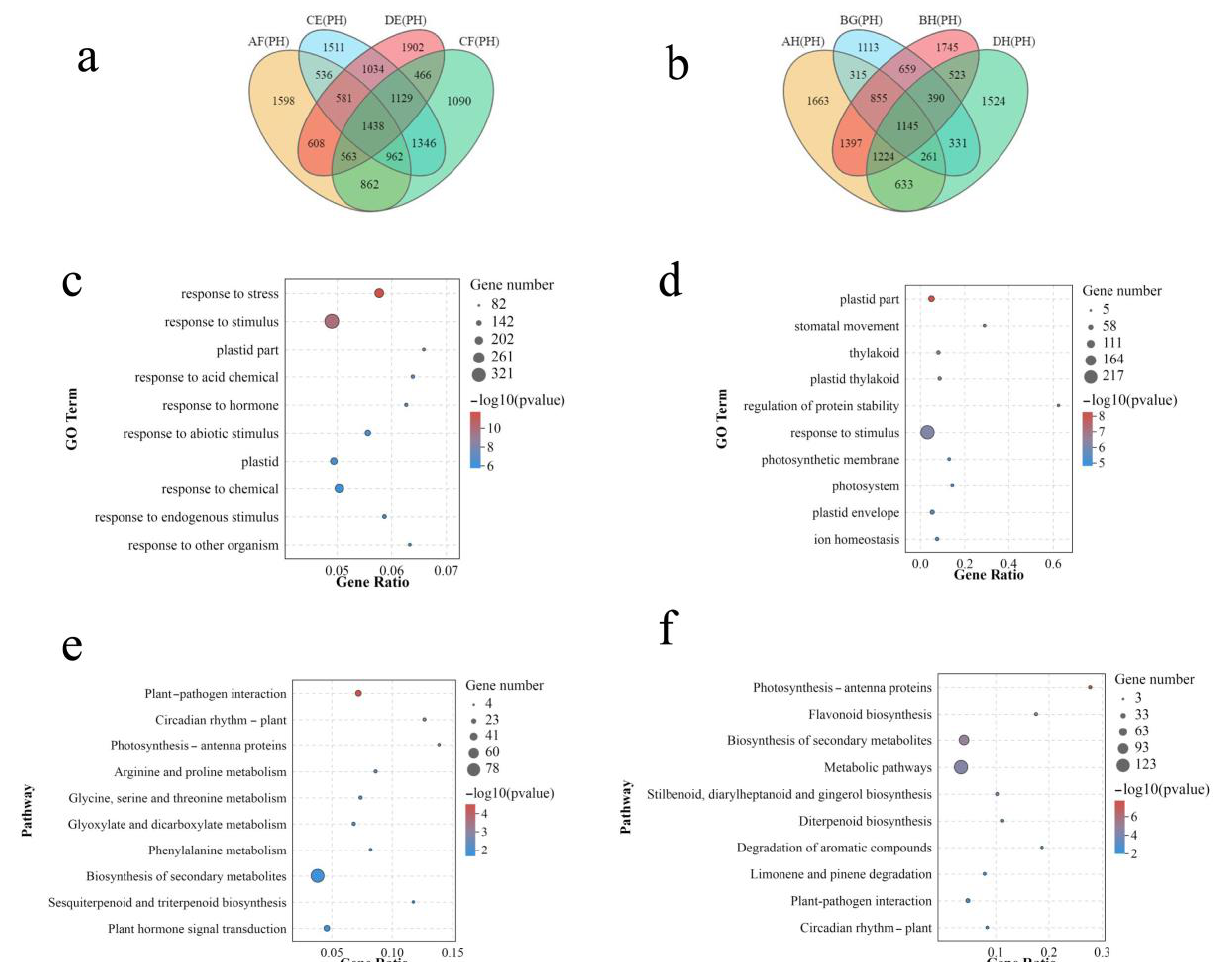
Figure 3. Analysis of genes related to heterosis. ( a ) Wien map of differentially expressed genes in strong heterosis hybrids. ( b ) Wien map of differentially expressed genes in weak heterosis hybrids. ( c ) GO enrichment of differentially expressed genes in strong heterosis hybrids. ( d ) GO enrichment analysis of differentially expressed genes in weak heterosis hybrids. ( e ) KEGG enrichment analysis of differentially expressed genes in strong heterosis hybrids. ( f ) KEGG enrichment analysis of dif- ferentially expressed genes in weak heterosis hybrids. The size of the bubble represents the number of genes contained in the pathway, and the color of the bubble represents the enrichment signifi- cance in the pathway.